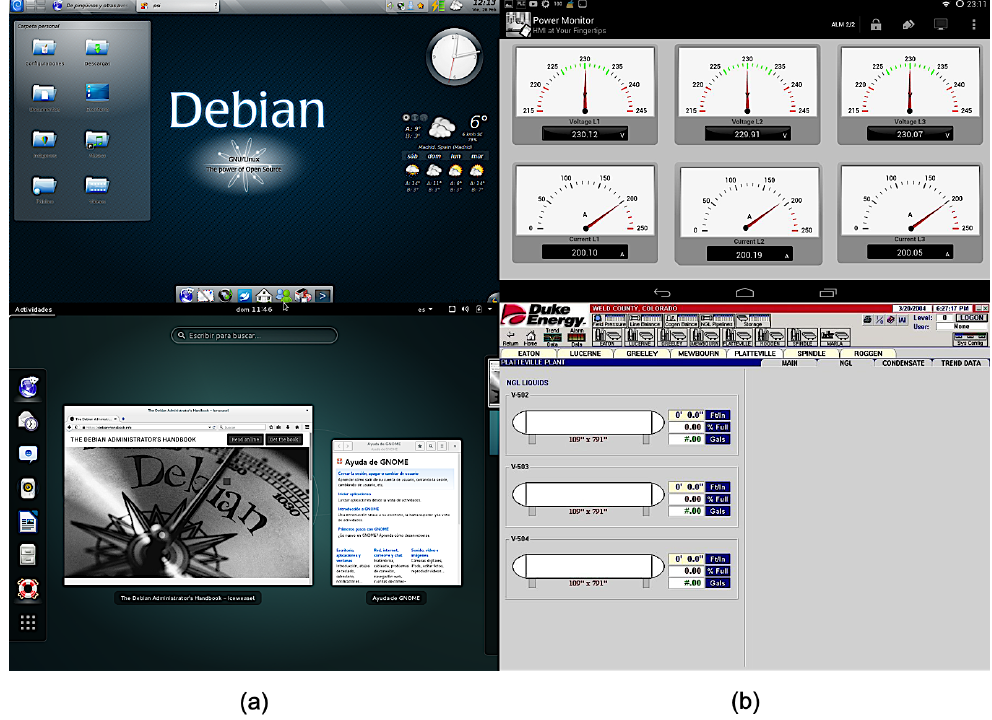
Figure 1. Information technology (IT) (column a ) and operational technology (OT) (column b ) sample images. IT systems focus on software management and data control, while OT systems help directly monitor device